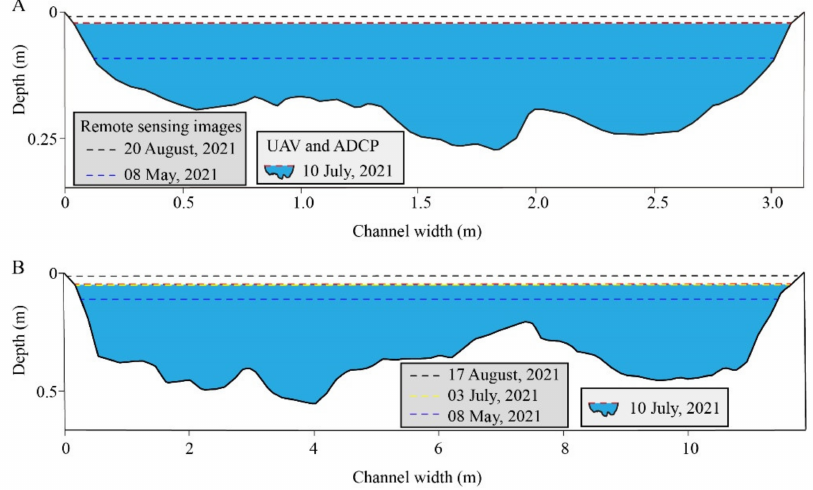
Figure 2. The profiles of sections ( A — top ) and ( B — bottom ) measured by ADCP and reconstructed by remote sensing